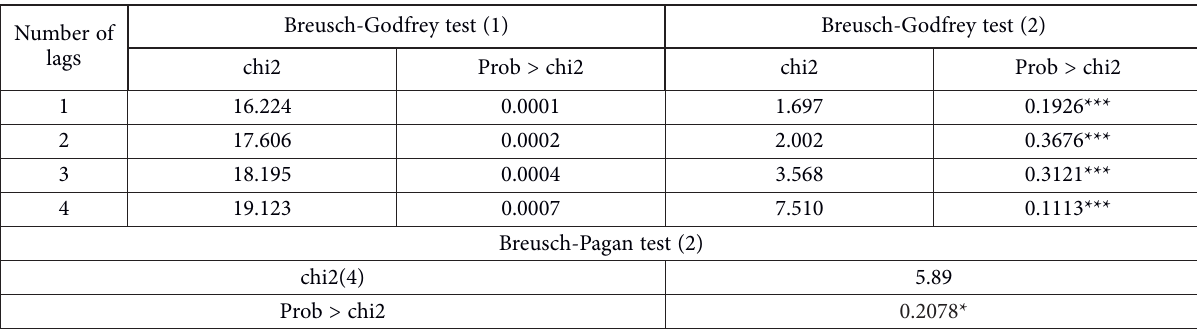
Table A3. The results of the Breusch-Godfrey test and the Breusch-Pagan test for the short-term equation in the symmetric model (source: own